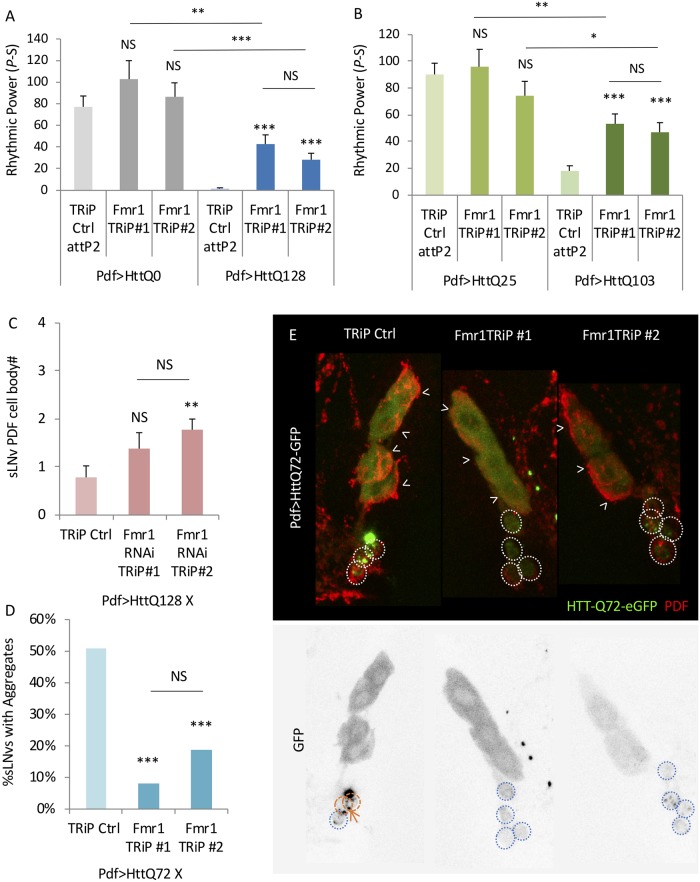
Fmr1 knockdown partially suppresses mHtt toxicity.A. Rhythmic power (P-S) is indicated for various genotypes including flies expressing HttQ0 (Pdf>HttQ0 in grey) or HttQ128 (Pdf>HttQ128 in blue) in PDF neurons in a TRiP RNAi library control background (TRiP Ctrl attP2) and expressing two independent Fmr1 TRiP RNAi lines (Fmr1TRiP #1 and #2; n = 13–41; *p<0.05, **p<0.01, ***:p<0.005, error bars represent standard error). B. Rhythmic power (P-S) is indicated for various genotypes including flies expressing HttQ25 or HttQ103 in PDF neurons (Pdf>HttQ25 or Pdf>HttQ103 in green) in PDF neurons in a TRiP RNAi library control background (TRiP Ctrl attP2) and expressing two independent Fmr1 TRiP RNAi lines (Fmr1TRiP #1 and #2; n = 16–42; *p<0.05, **p<0.01, ***:p<0.005, error bars represent standard error). C. The number of sLNv present per brain hemisphere is indicated for various genotypes where either two independent Fmr1 RNAi (Fmr1 TRiP #1/2) or TRiP RNAi library control (TRiP Ctrl) and HttQ128 are expressed is shown (n = 9–14; *p<0.05, **p<0.01, ***:p<0.005). D. Percentage of sLNvs (labeled with PDF in red) at age day 7 containing HttQ72-eGFP aggregates (in green) in a TRiP RNAi library control background (TRiP Ctrl) and expressing two independent Fmr1 TRiP RNAi lines (Fmr1 TRiP #1/2) is quantified (n = 32–65; *p<0.05, **p<0.01, ***:p<0.005, error bars represent standard error). E. Representative images of sLNv and lLNv for corresponding genotypes in D are shown. White arrowheads indicate lLNvs. White dot circles label sLNvs in the merged figure. Orange dash circles label sLNvs with aggregates while blue dot circles label sLNvs without aggregates in the grey scale of the green channel. Example aggregates are pointed out by orange arrows.